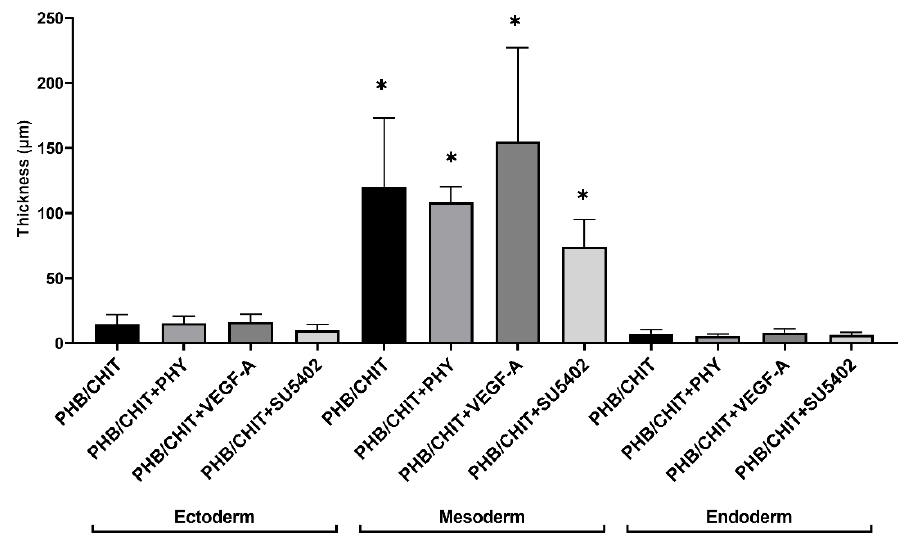
Figure 6. Thickness of the CAM layers in the surrounding area of the scaffold depending on the treatment of the scaffolds. Experiments were repeated three times, and data are shown as thickness of the CAM layers in µm ± SD (biological replicates: 6 samples for each group, technical replicates: 120 for each group). * p < 0.0001.